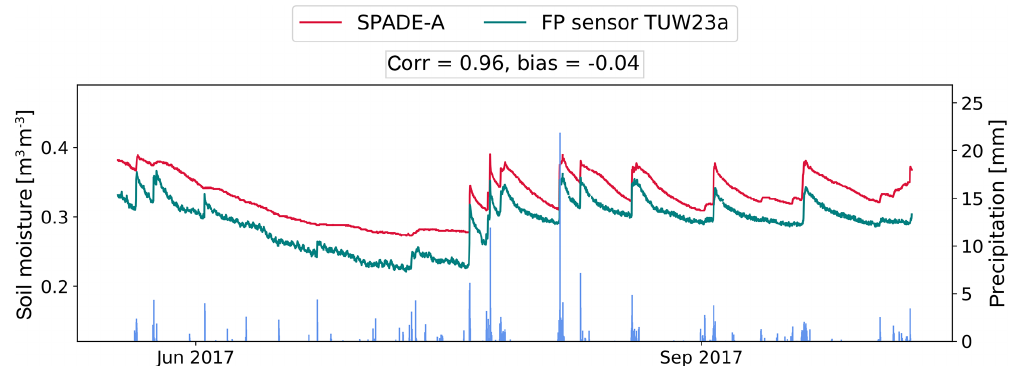
Figure 9. Soil moisture time series of FP sensor TUW23a and professional probe Hoal_11 at a depth of 0.05m, installed next to each other, in good